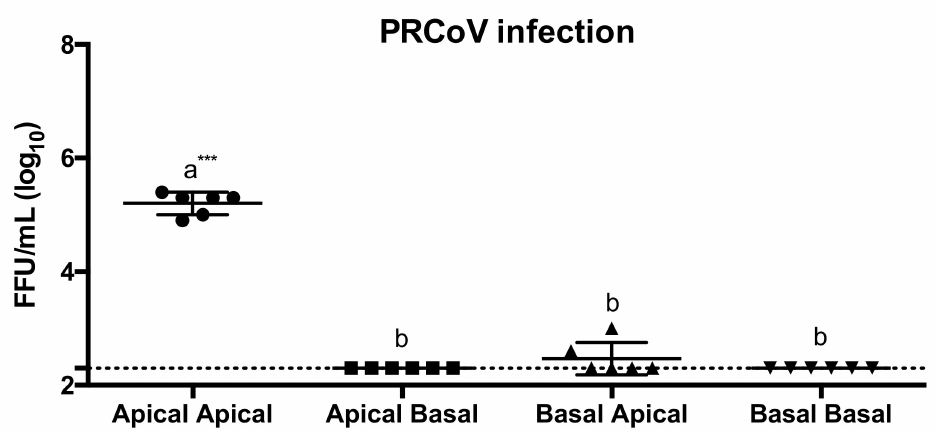
Figure 1. Entry and release of PRCoV Bel85 on well-di ff erentiated porcine tracheal epithelial